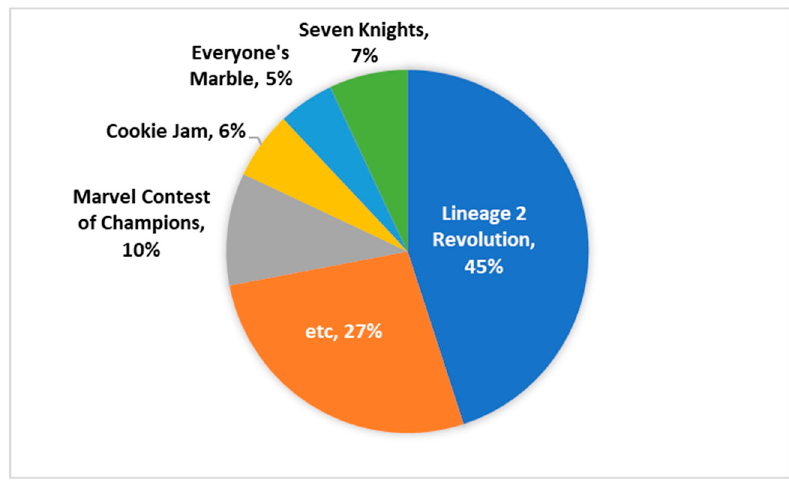
Figure 3. Sales Breakdown by Products (%) [18]. Graph created by the authors. Source: [18]